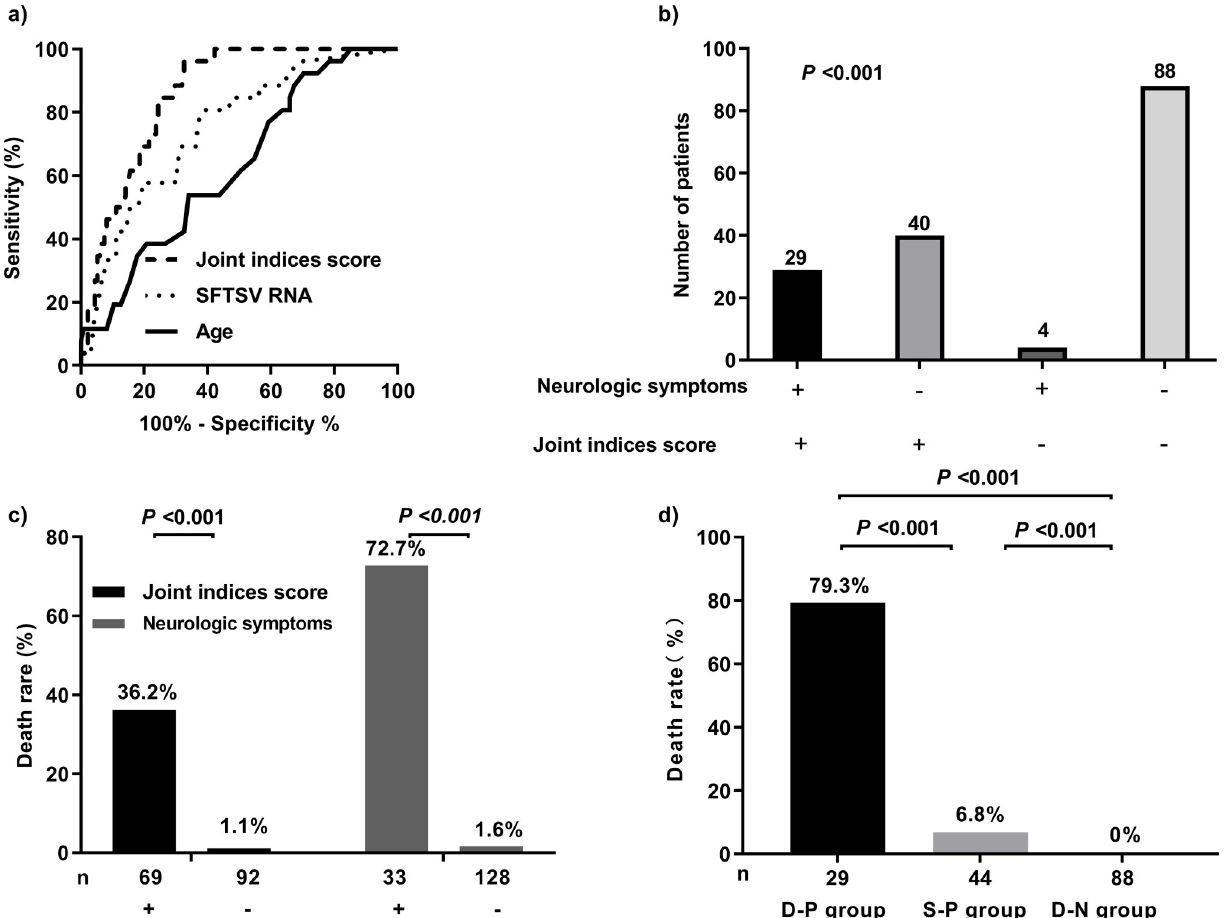
Fig 1. A clinical scoring model for predicting mortality in patients with severe fever with thrombocytopenia syndrome (SFTS). (A) Receiver operating characteristic (ROC) curve for predicting mortality in patients with SFTS. (B) Consistency between joint indices score and neurologic symptoms. (C) Mortality distribution of patients with SFTS according to each indicator. (D) Mortality distribution of patients with SFTS according to both combined indicators. Note: Joint indices score = Age + 10 × SFTSV RNA (lg) + 30 × Gastrointestinal bleeding. D-P: double-positive, S-P: single- positive, D-N: double-negative, M-G: modeling group, V-G: verification group.